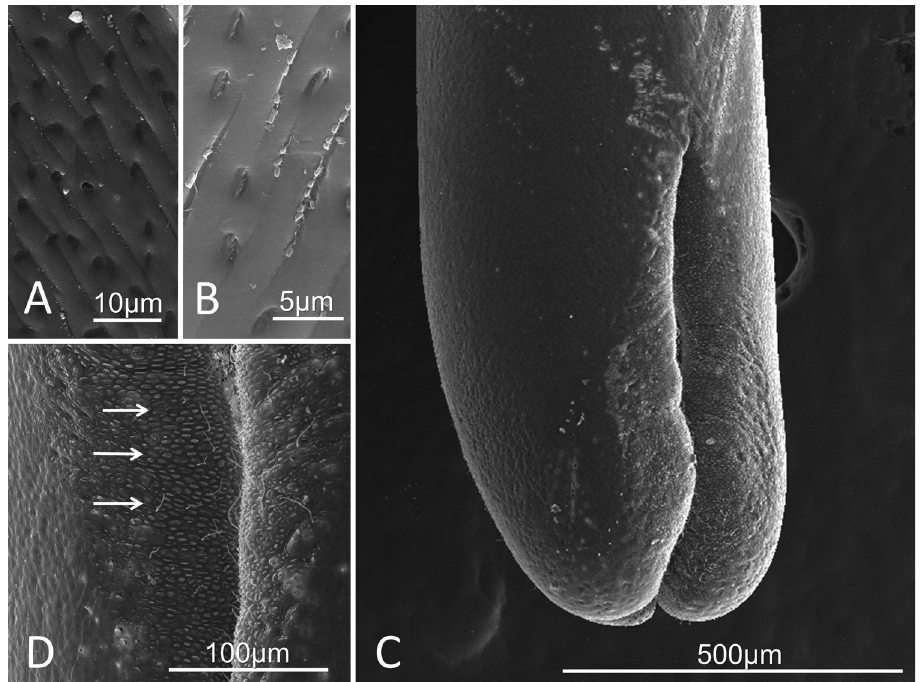
Figure 2. Paragordius amicus sp. n. adult female from the Santa Rita Mountains A–B Midbody cuticle exhibiting transverse striations made of ridges separated by furrows A In some areas with hollow round to oblong indentations B In other areas with more oblong indentations containing structures C Trifurcat- ing posterior. Note the cuticle features that can be seen on the interior surface of the lobes D Increased magnification of the lobes showing the oblong mounds (arrows). Note the long and thin hairs extending from some of the furrows between the